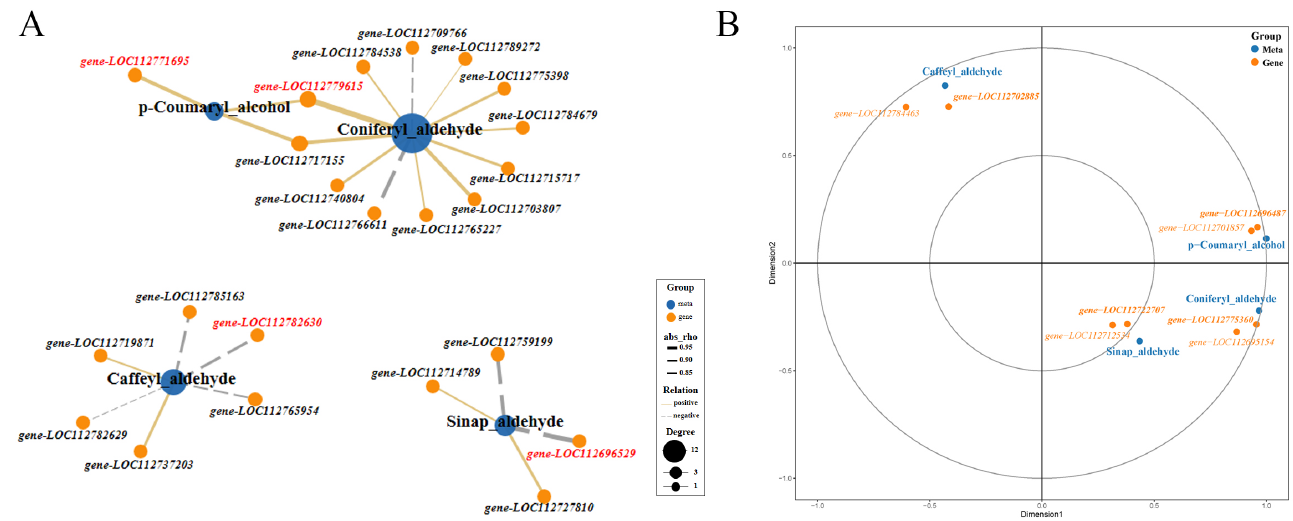
Figure 7. Pearson analysis of the correlation between metabolites and genes involved in monolignol biosynthesis and canonical correlation analysis (CCA) of metabolites and ABC transporter genes. ( A ) Correlation network graph was generated by considering only the strongest correlations (Pear- son’s rho ≥ 0.80). Genes with the highest correlation with metabolites are highlighted in red. ( B ) CCA of metabolites and ABC transporter genes. In the figure, four regions are distinguished by the cross. In the same region, the farther away from the origin, the closer the mutual distance, and the higher the correlation. Metabolites are colored in blue, genes are colored in orange. Bold font indicates key genes.